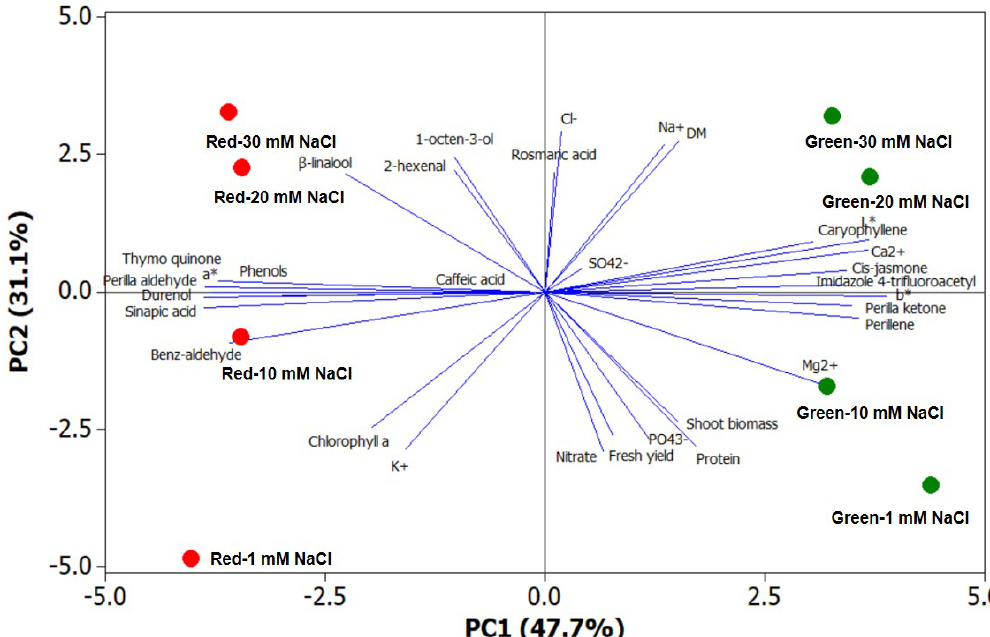
Figure 1. Principal component loading plot and scores of principal component analysis (PCA) of colorimetric data (L*, a*, b*), fresh yield, dry biomass, dry matter content, mineral concentrations (NO 3 − , N, PO 43 − , K + , SO 42 − , Ca 2+ , Mg 2+ , Na + , Cl − ), protein and chlorophyll a contents, phenolic composition (rosmarinic, caffeic and sinapic acids), total phenolic content and aroma volatile compounds in green and red perilla grown under increasing NaCl concentration in the nutrient solution (1, 10, 20 or 30 mM NaCl).